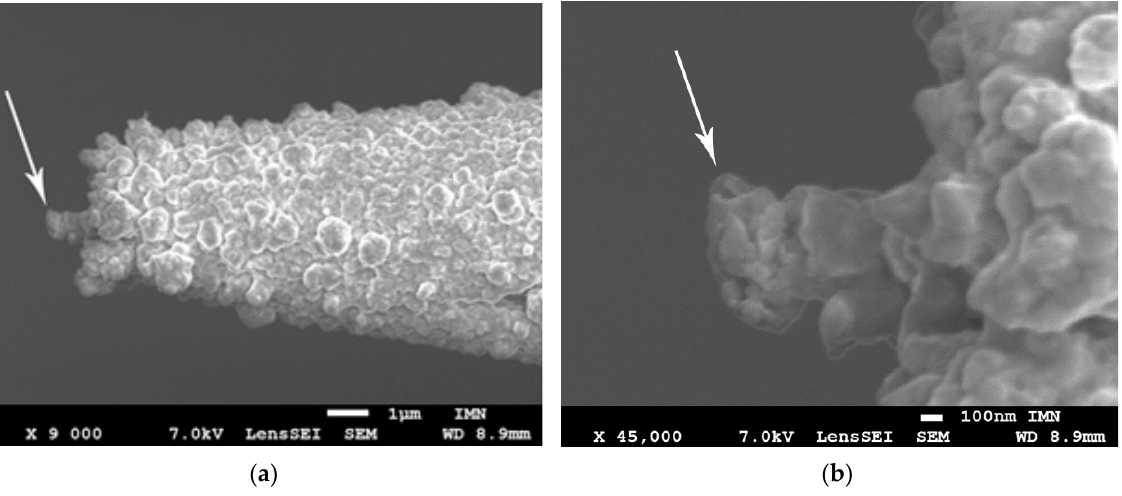
Figure 1. ( a ) Scanning electron micrograph (SEM) of a Cu needle tip after passing electric current through the needle–electrolyte–anvil system. Distinct areas of growing dendrites are seen. The ar- row points to the most developed dendrite that will form a point contact. ( b ) SEM picture of the